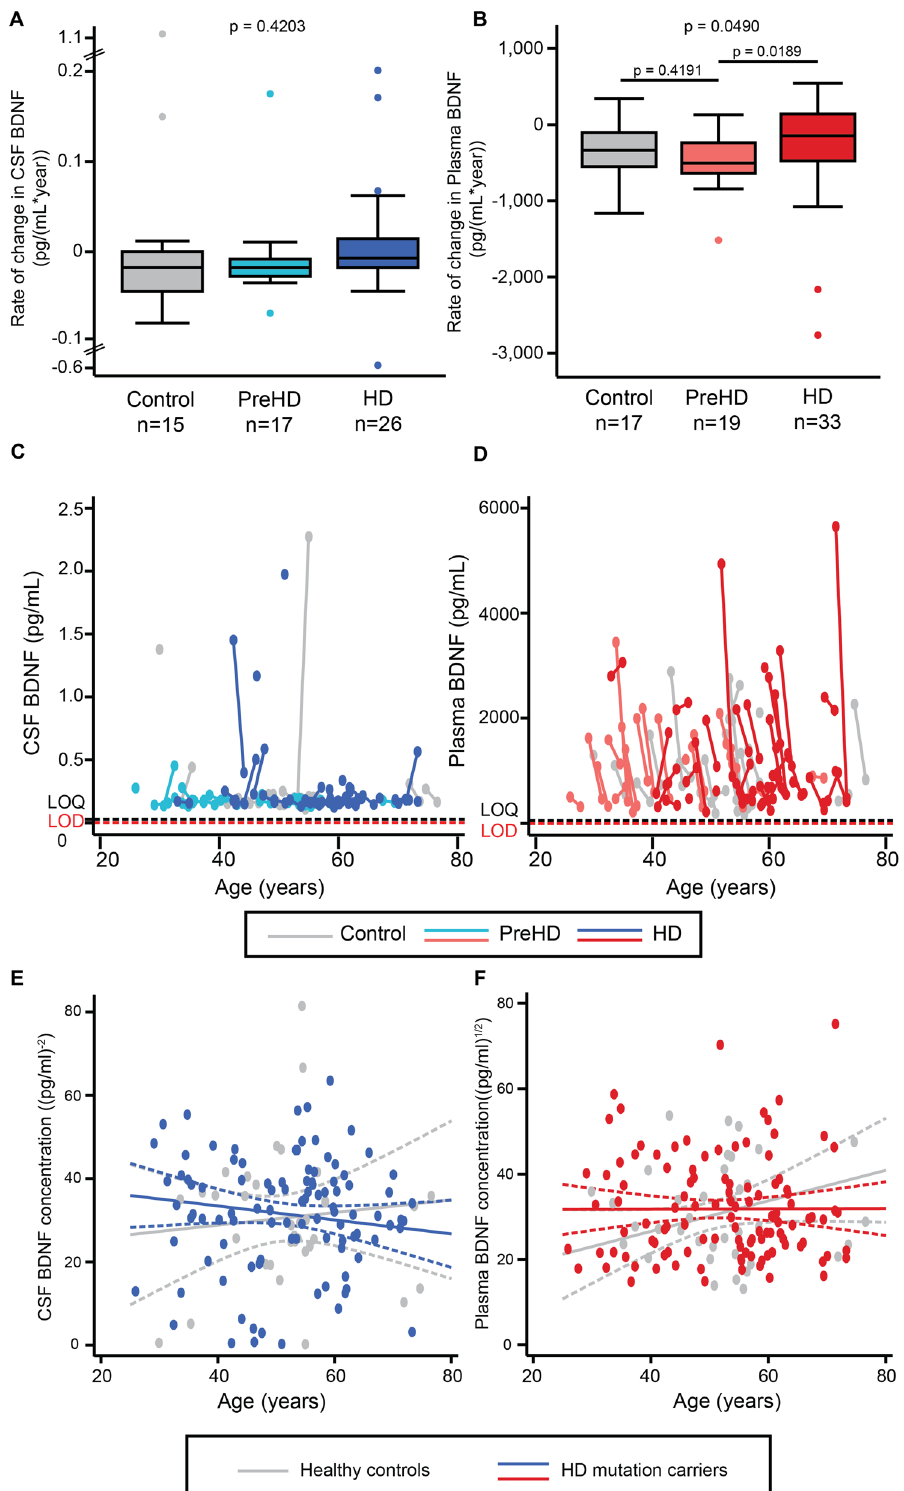
Figure 3. Longitudinal analyses in CSF and plasma. Rate of change in the concentration of BDNF in CSF ( A ) and plasma ( B ) in healthy controls, premanifest HD (PreHD), and manifest HD (HD) patients. Comparison were generated with general linear models. Relationship between raw CSF ( C ) and plasma BDNF values ( D ) and age in years. The limit of quantification (LOQ) and limit of detection (LOD) of the SIMOA assay are indicated. Longitudinal trajectories were studied with mixed effect models, which are adjusted for covariates ( E , F ). CSF, cerebrospinal fluid; BDNF, brain-derived neurotrophic factor; HD, manifest HD mutation carriers, PreHD, premanifest HD mutation